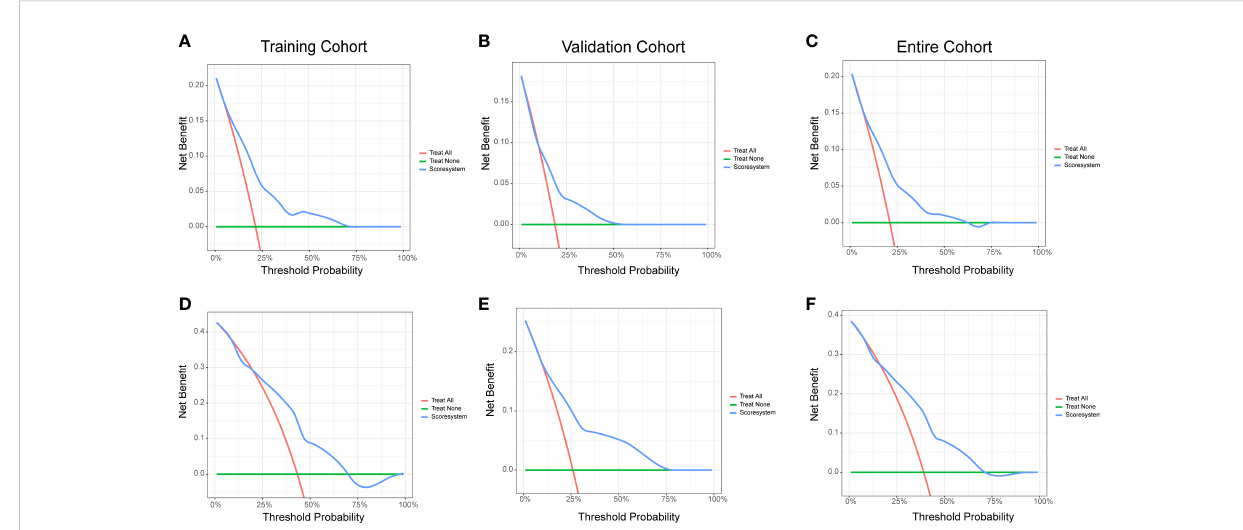
FIGURE 4 Decision curve analysis of the risk score system for the CVAE-free survival prediction of NDMM patients. (A) One-year survival in the training cohort. (B) One-year survival in the validation cohort. (C) One-year survival in the entire cohort. (D) Two-year survival in the training cohort. (E) Two-year survival in the validation cohort. (F) Two-year survival in the entire